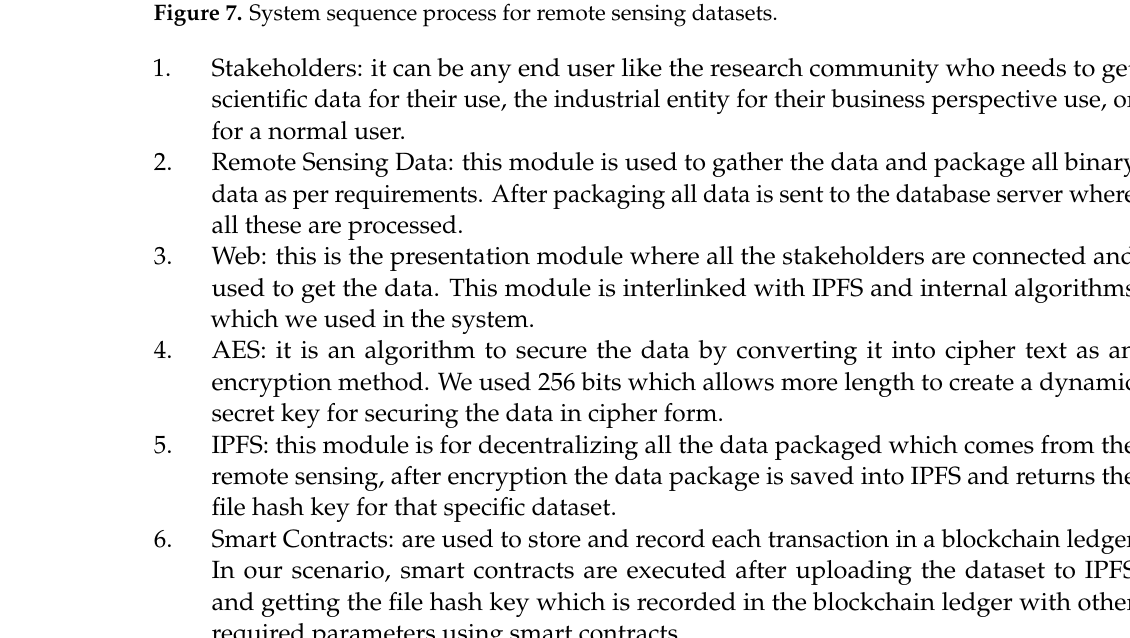
Figure 8. The computational time for function execution to store and access the data in IPFS and Blockchain.